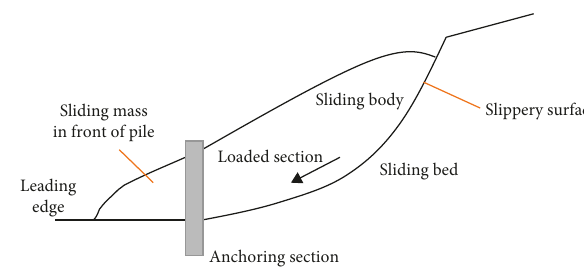
Figure 6: Force diagram of frame-type antislide pile.